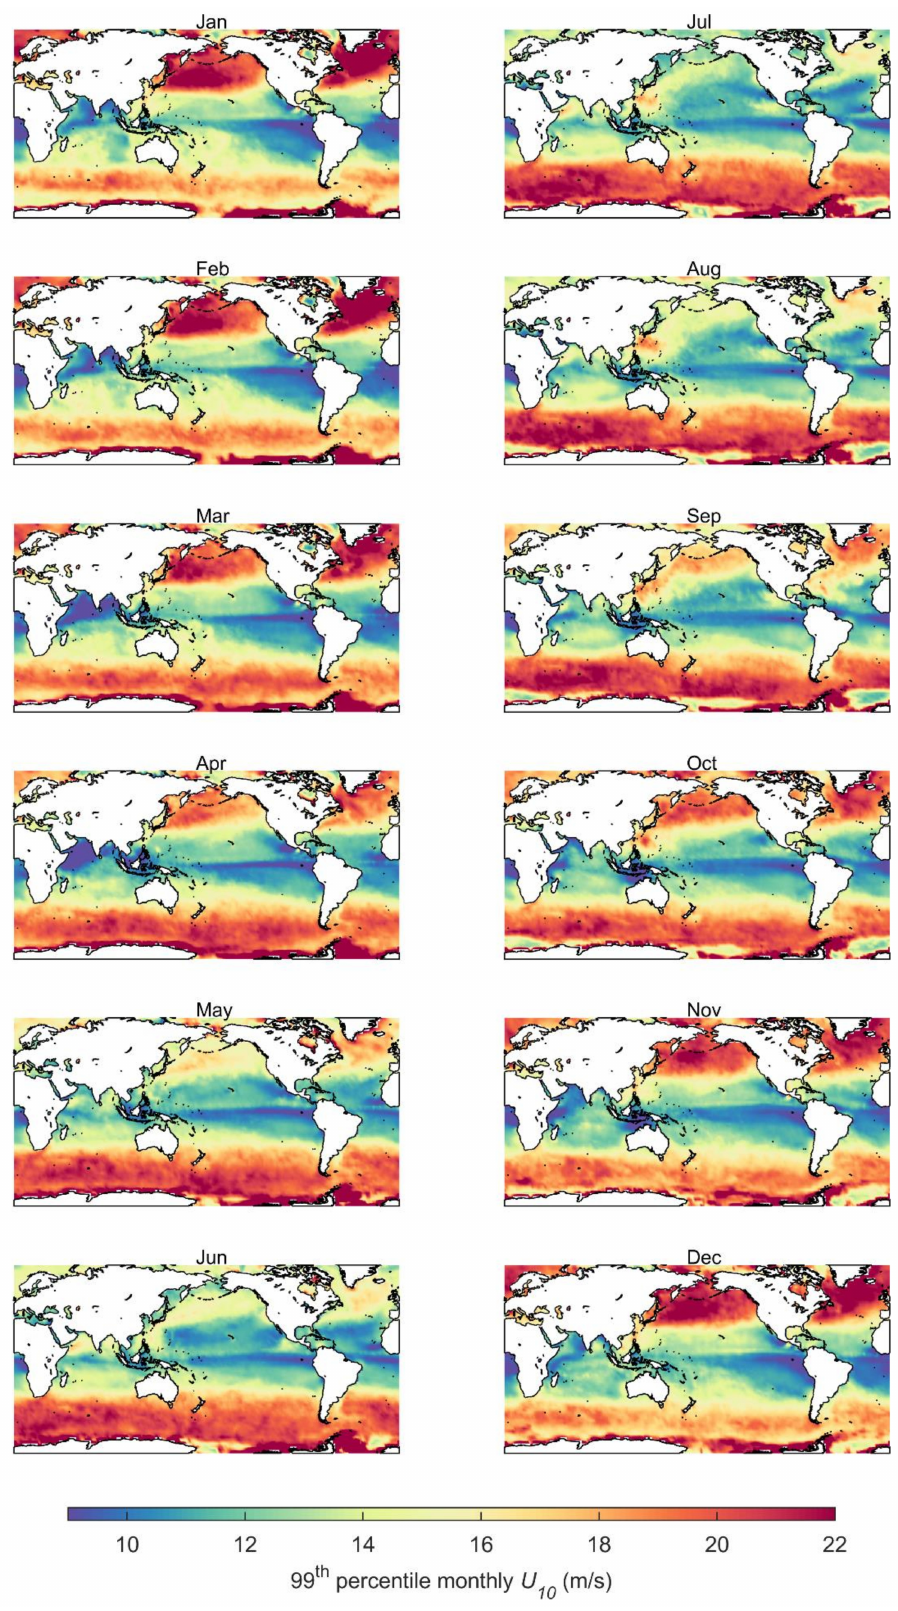
Figure 3. The 99th percentile global monthly wind speed at a reference elevation of 10 m ( U 10 ) from scatterometer data, U 10 ( 99 ) . The data were gridded at 2 ◦